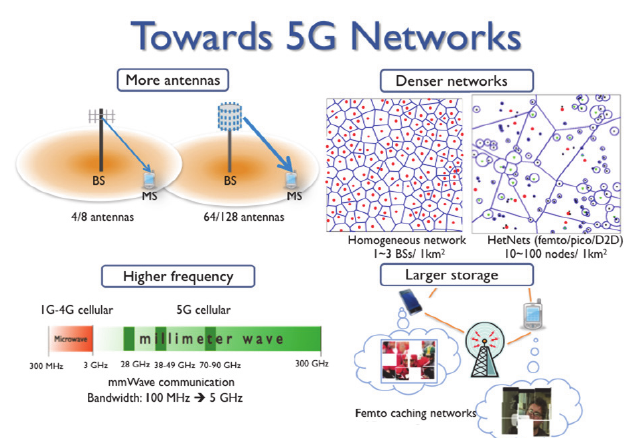
Fig. 2. Deployment of future 5G heterogeneous cellular